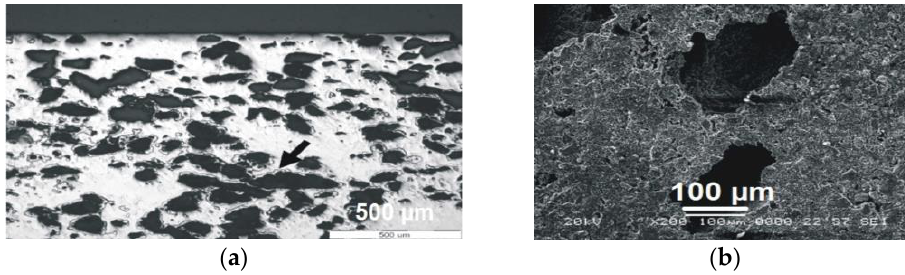
Figure 2. Sintered c.p. Ti sample: ( a ) general aspect (optical microscopy), unetched sample; ( b ) details on the shape of pores (SEM).